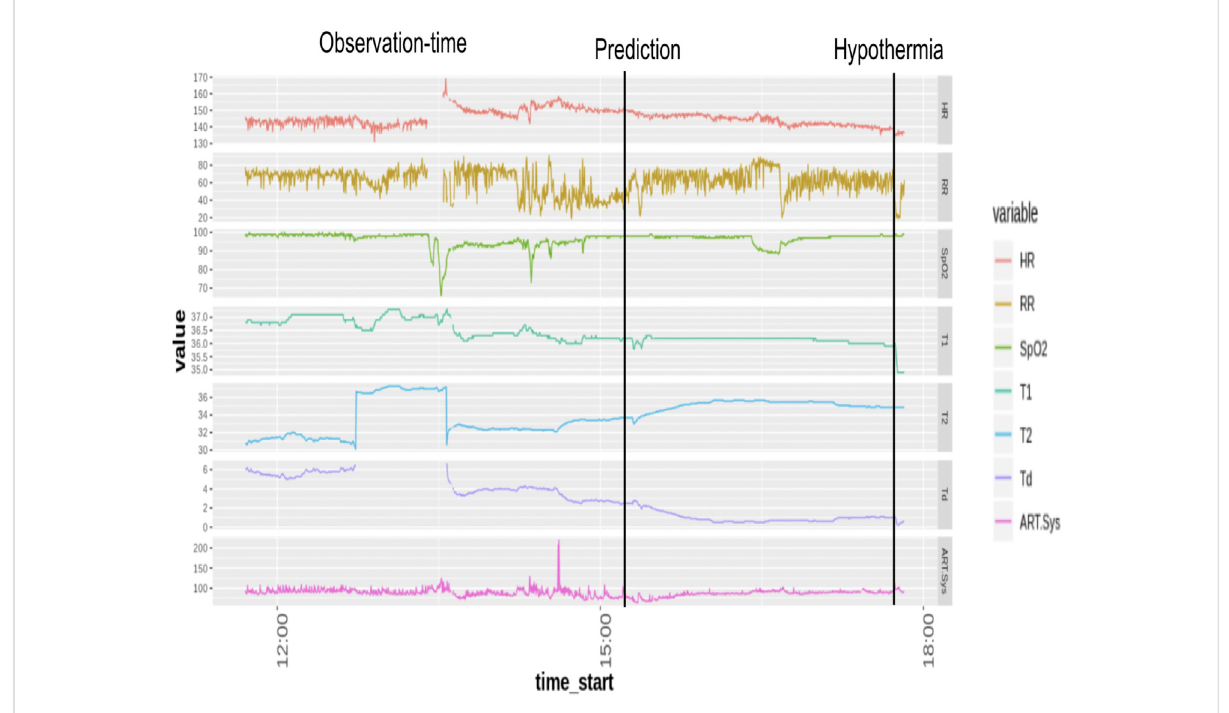
FIGURE 1 Physiological variables for prediction of Hypothermia in